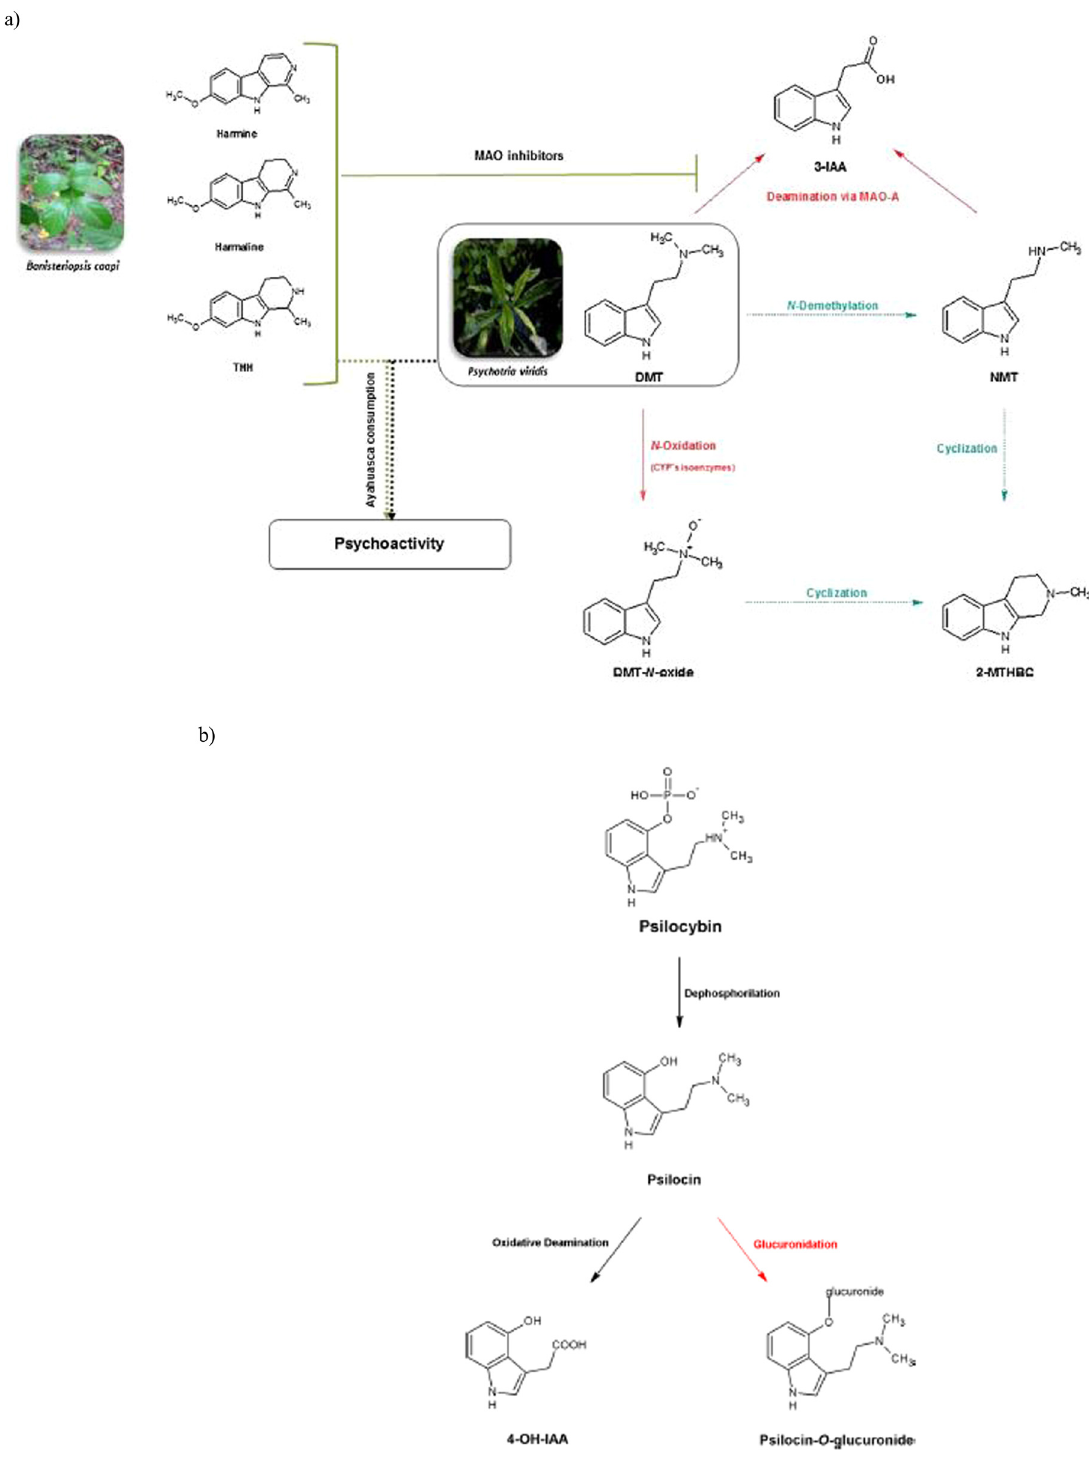
Figure 5: ( a ) Minor ( blue arrows ) and major ( red arrows ) metabolic pathways for DMT in humans; ( b ) metabolic pathways for psilocybin in humans [ 408 ]